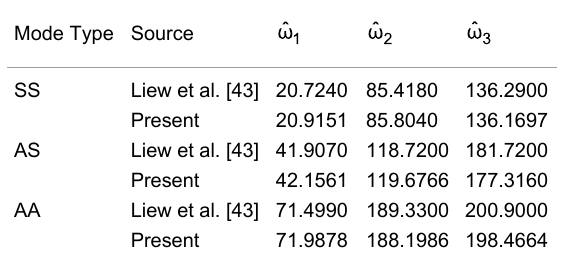
Table 4: Frequency parameters, for square SSSS isotropic homogeneous plates with a square cutout with ν = 0.3, c/a = 0.4 and a/h =